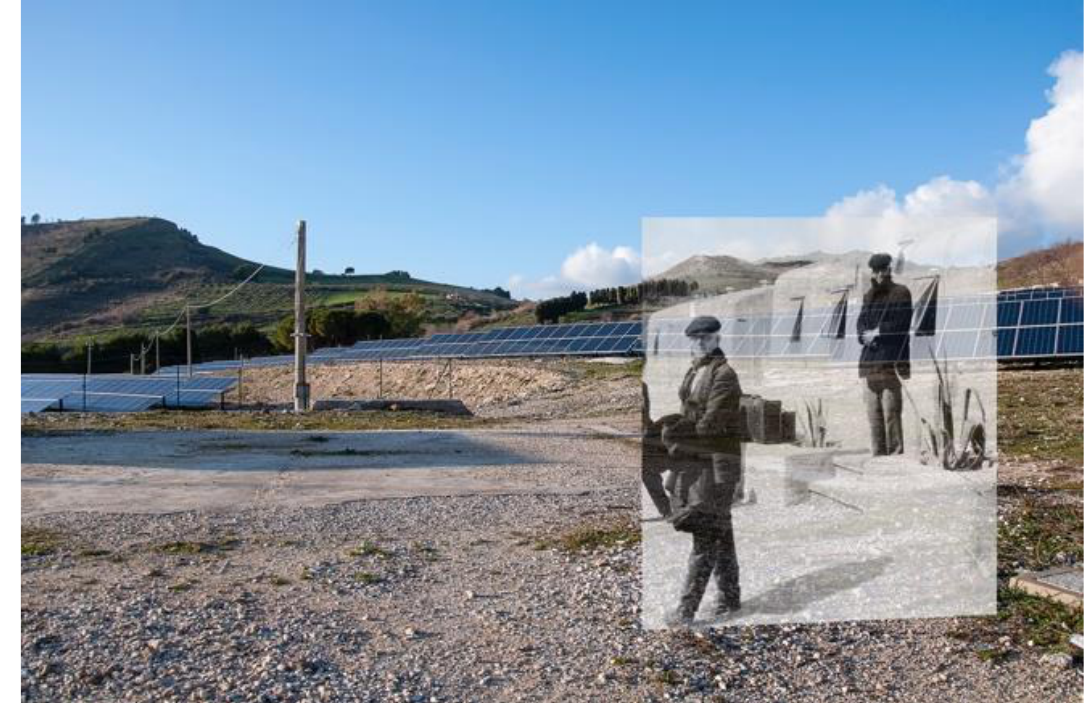
Figure 17. Villaggio Salaparuta, people at the temporary barrack camp town hall (Photo: Scafidi for L’Ora, Archivio de L’Ora, Biblioteca Regionale Siciliana “Alberto Bombace”, Palermo) and photo- voltaic system in the Salaparuta area (Photo by the authors, Salaparuta 2020).